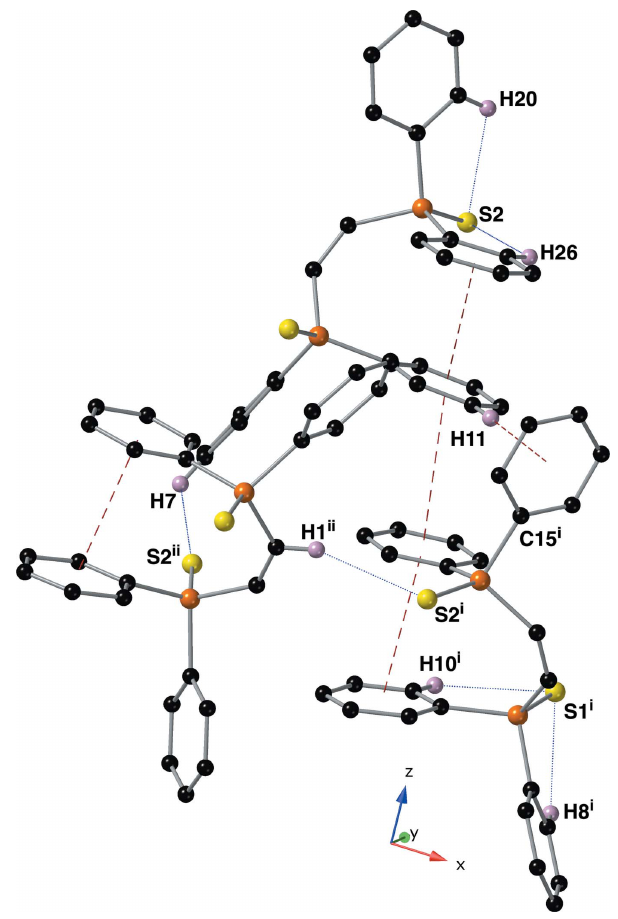
Figure 3 A figure depicting the intra- and intermolecular interactions found in crystals of compound I using a ball-and-stick model with standard CPK colors. Hydrogen bonds are drawn using blue dotted lines while (cid:2) – (cid:2) and C—H (cid:2)(cid:2)(cid:2) (cid:2) interactions are drawn with red dashed lines. Only hydrogen atoms involved in an interaction are shown for clarity. Symmetry